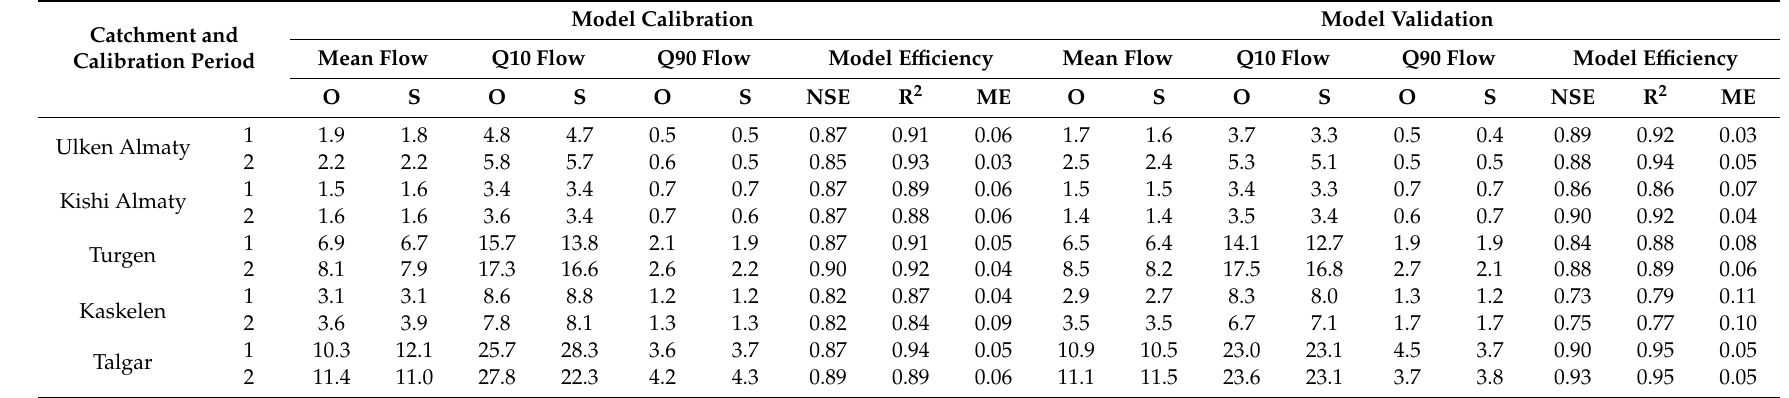
Table 4. Statistics of river runo ff and model e ffi ciency during model calibration and validation with 1990 and 2006 glacier masks. ‘Year’ refers to the year for which glacier mask was derived. ‘O’ stands for observed; ‘S’ for simulated values. The 1985–1995 and 2001–2005 (2007–2010 for the Talgar) periods are denoted as ‘1’ and